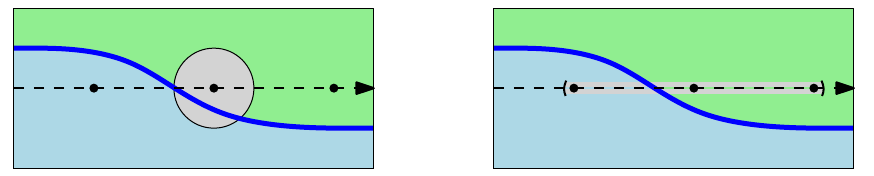
Figure 7: Trajectory neighborhoods: geographic (right) or along the trajectory